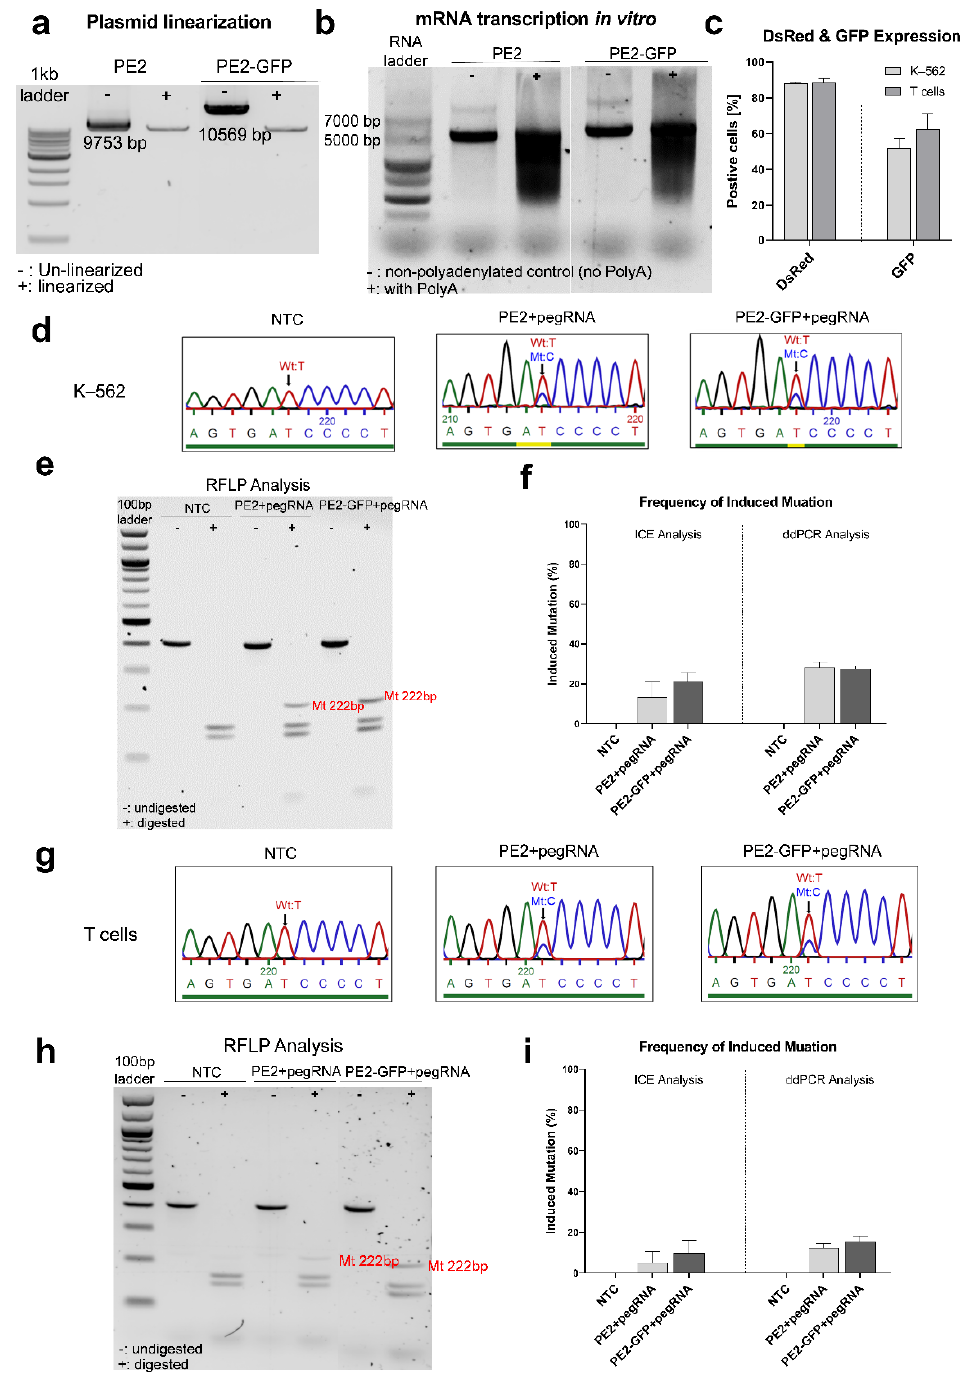
Figure 5. Prime editing in K-562 cells and healthy donors’ T cells to induce the IL2RG c.458T>C mutation. Gel visualization of ( a ) linearized plasmids and ( b ) in vitro synthesized mRNAs. Inducing the IL2RG c.458T>C mutation in K–562 cells (n = 2) and healthy donors’ T cells (n = 3) was carried out using prime editing with PE2 and PE2-GFP mRNA and pegRNA1. The DsRed and GFP expressions, as transfection controls, were evaluated 24 h after electroporation. ( c ) Up to 88% of the K–562 cells and 91% of the T cells expressed DsRed; 41–62% of the K–562 cells and 47–76% of the T cells expressed GFP. The gDNA was acquired for a genomic analysis of editing efficiency two days post-electroporation. In K–562 cells, ( d ) PE2 mRNA-pegRNA and PE2-GFP mRNA-pegRNA-transfected cells showed the induced mutant base c.458C (the blue, red, green, and black peaks stand in place of bases C, T, A, and G respectively); ( e ) an RFLP analysis showed that a band with the expected size (222 bp) after